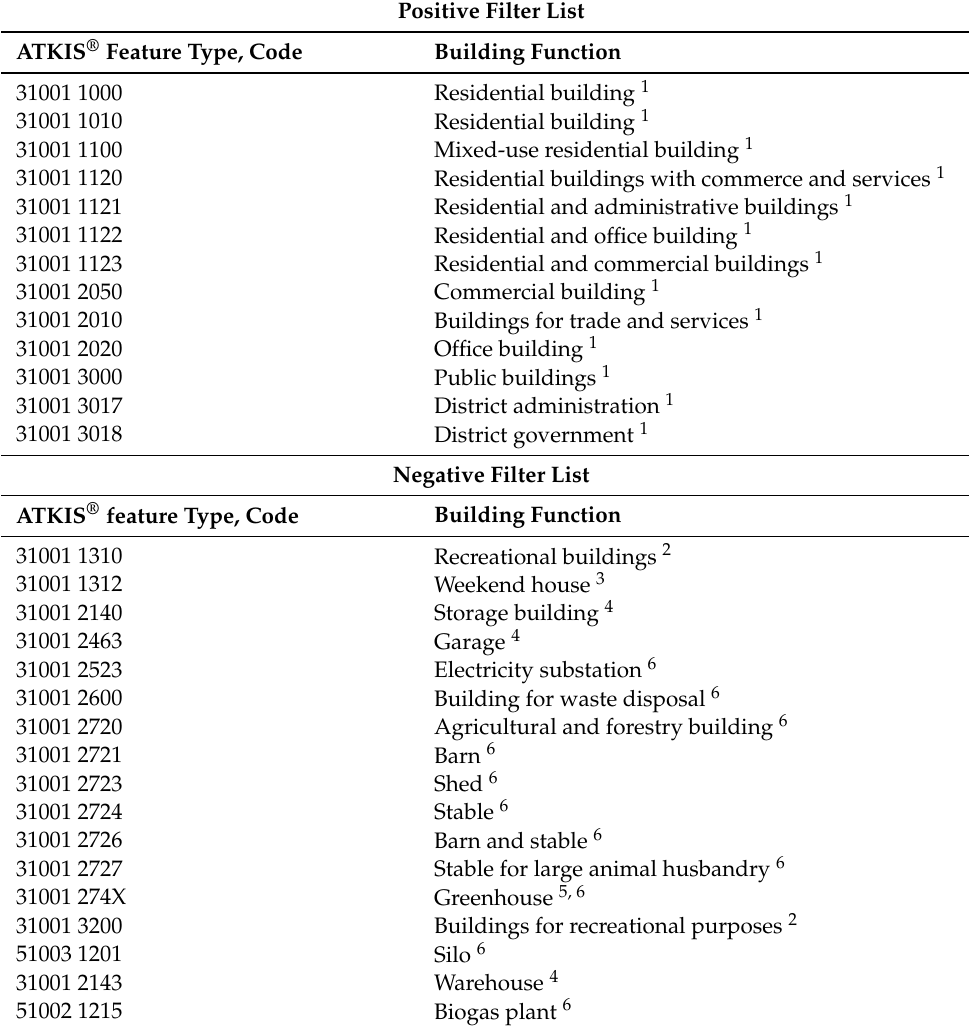
Table 1. Building functions used for filtering: The functions in the lists have been selected in such a way that they can be assigned relatively clearly to the positive and negative lists, and almost all relevant building functions are